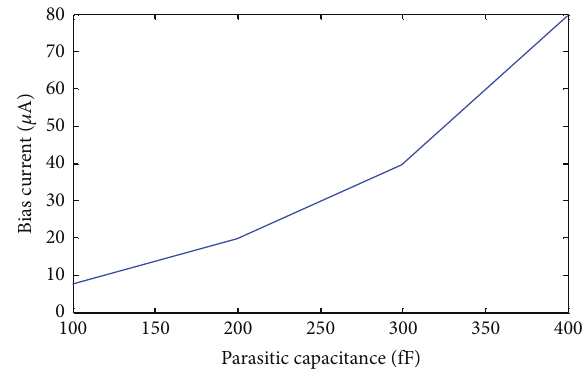
Figure 1: Minimum bias current as a function of the parasitic capacitance.